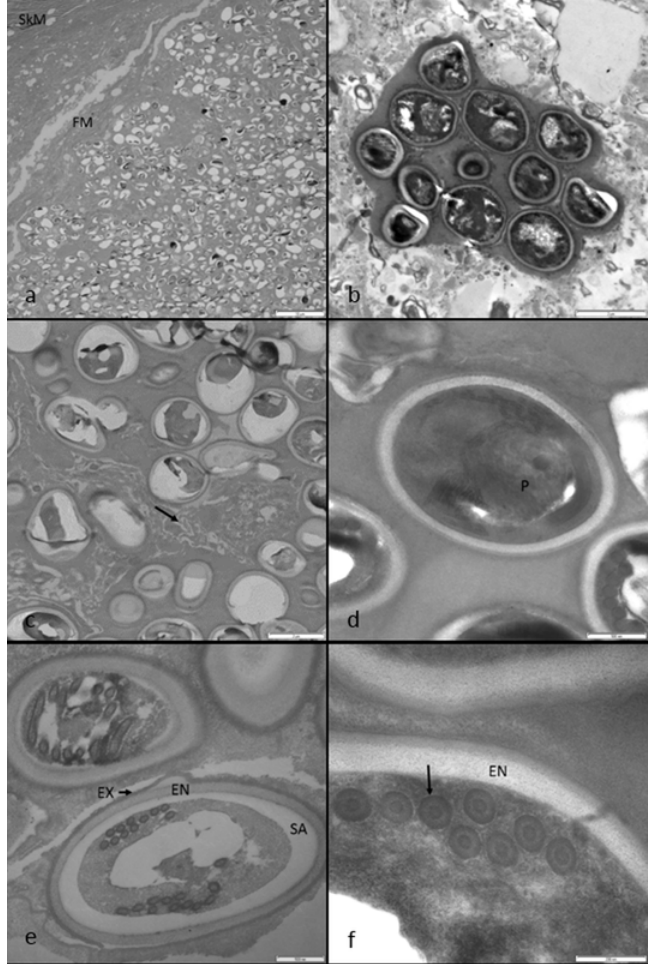
Fig 3. Transmission electron micrographs of sea snake microsporidia a) Cyst containing hundreds of mature microsporidian spores bound by a wall of fibrillar material (FM) in the skeletal musculature (SkM). b) Spores embedded in dense ground substance and apparently surrounded by sporophorous vesicle membranes were occasionally observed. c) Spores were usually embedded in heterogenous ground substance with occasional fibrillar/membranous patches (arrow). d) An irregularly lamellated polaroplast (P) was occasionally seen in sections of mature spores. e) The spore wall consisted of a thin electron-dense exospore wall (EX) with a roughened surface lacking distinct surface projections or protrusions, an inner thick electron-lucent endospore wall (EN) often overlying a shrinkage artifact (SA) separating it from the spore cytoplasmic contents. f) Section through the periphery of a mature spore showing internal cross-sectional detail of isofilar polar filaments arranged in two loose ranks (arrow).